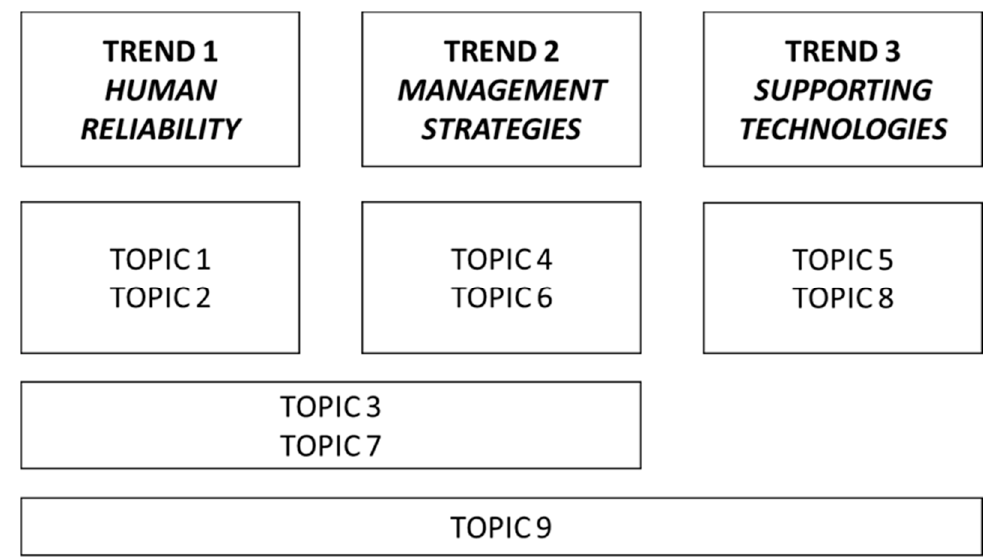
Figure 9. Topics grouped into the research trends identified.